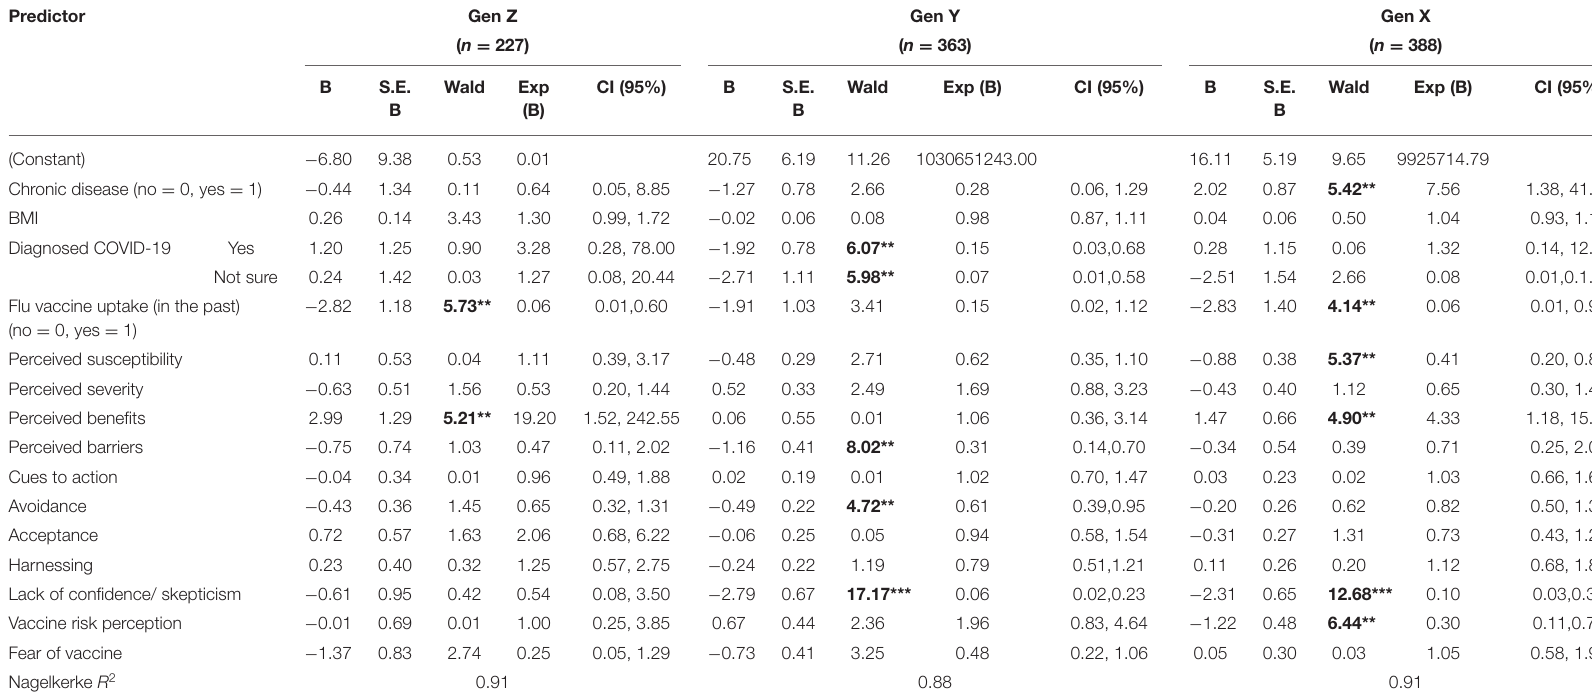
TABLE 2 | Multivariate binary logistic regression results on COVID-19 vaccine uptake in women of Gen Z, Gen Y, and Gen X. Predictor Gen Z Gen Y Gen